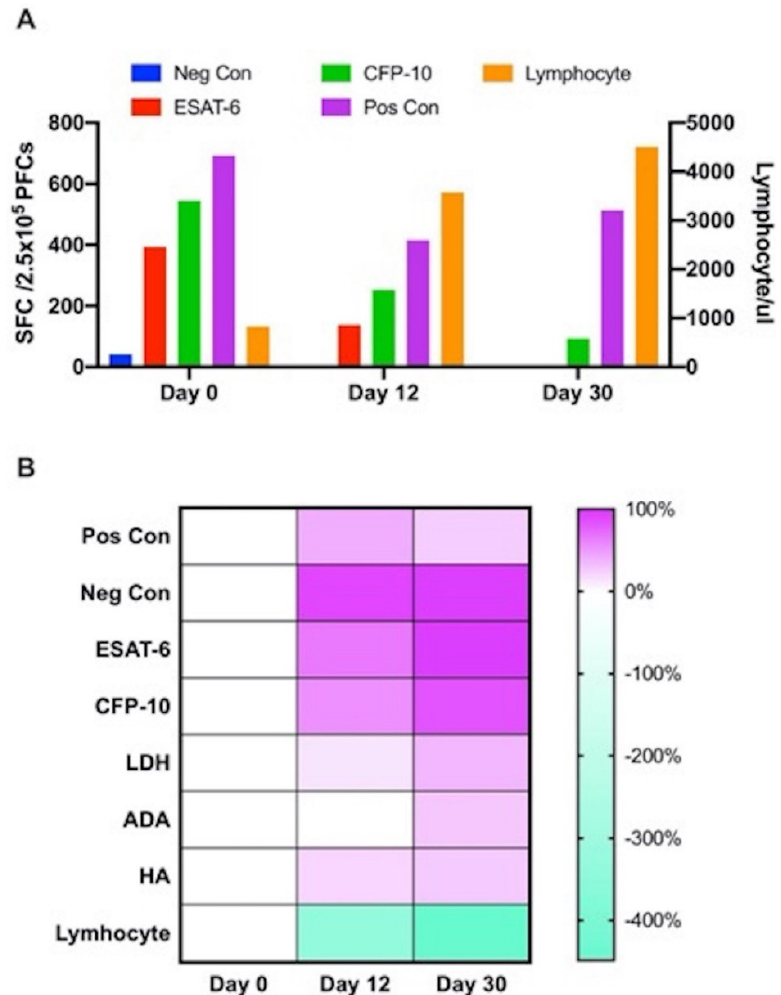
Figure 2. Time-dependent changes in biomarkers from the pleural fluid. ( A ) Spot-forming cells (SFCs) of pleural lymphocytes in the T-spot assay. Left y axis shows the SFC number of negative control (Neg Con), ESAT-6, CFP-10, and positive control (Pos Con), whereas the right y axis shows the number of lymphocytes. ( B ) Heat map of the percent decrease in the expression level of each marker. The percent inhibition is presented in colors ranging from green to pink, as shown in the key, and was calculated as ((Day 0–Day X) / Day 0)) × 100%. Day 0 is the first day of visit. Day 12 indicates four days after the anti-TB drugs were started. Day 30 was 22 days after the anti-TB drugs were started. The results were from the mean of duplicate assay.